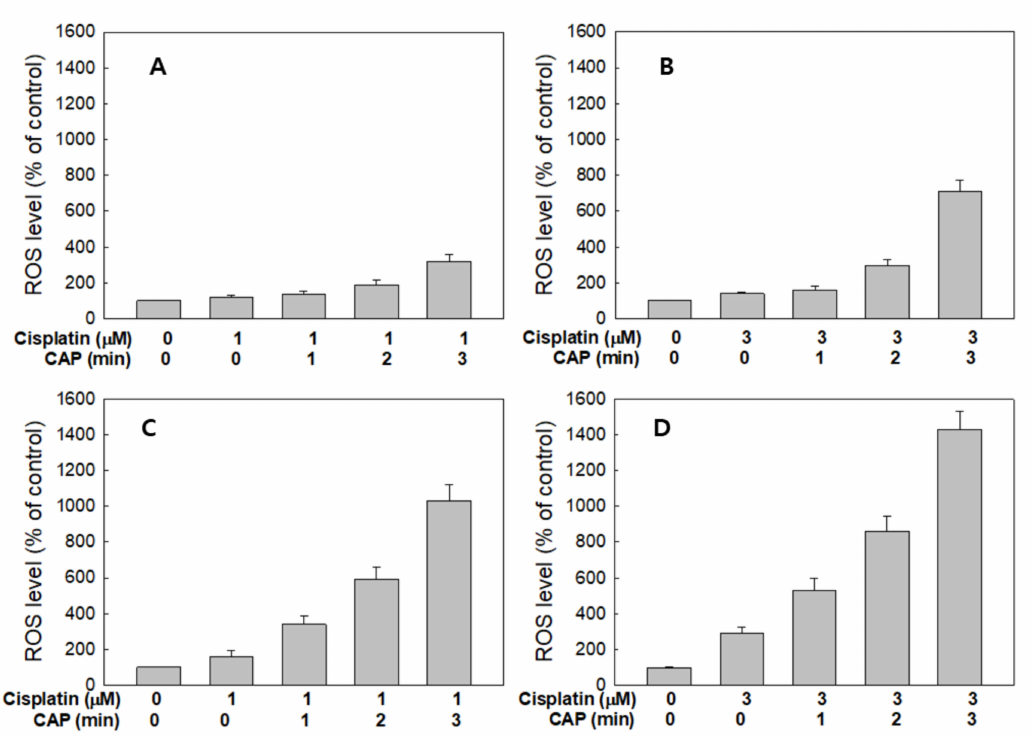
Figure 7. Synergistic combination e ff ect of cisplatin and plasma on reactive oxygen species (ROS) generation. ROS generation of HGF-1 ( A , B ) and SCC-15 cells ( C , D ) after the CAP exposure (1, 2 and 3 min) with 1 mM (a and c) and 3 µ M (b and d) of